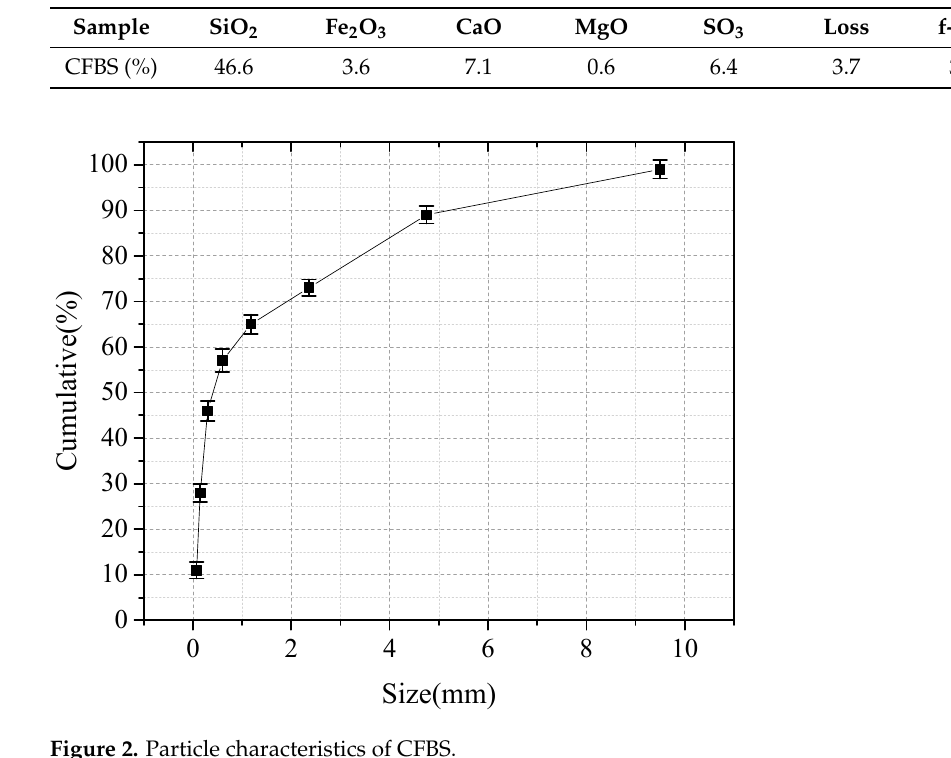
Table 1. Chemical composition of CFBS/%.